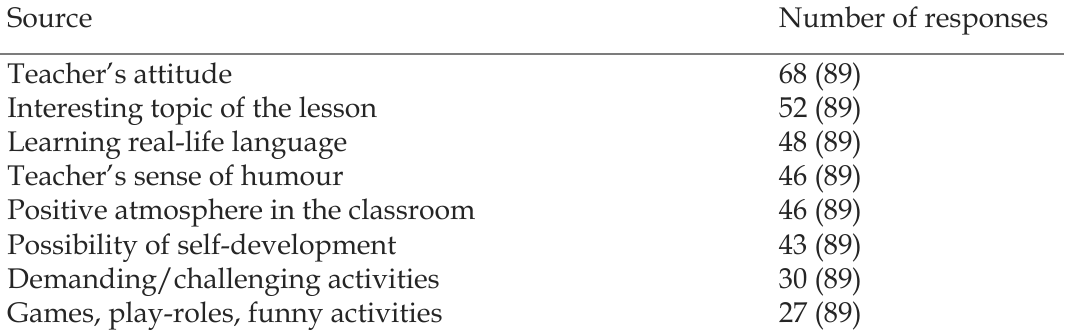
Sources of FLE and the frequency of responses Source Number of